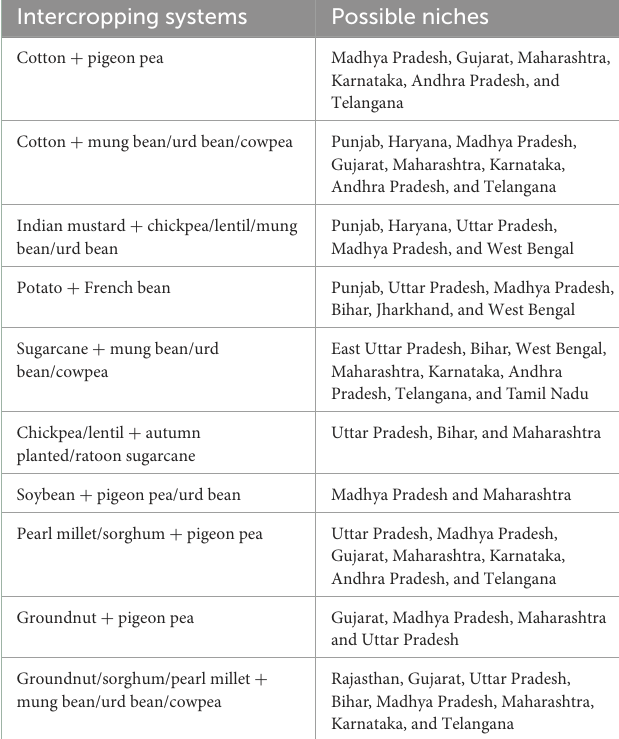
TABLE 7 Possible intercropping systems capable of large-scale advancement and adoption in India. Intercropping systems Possible